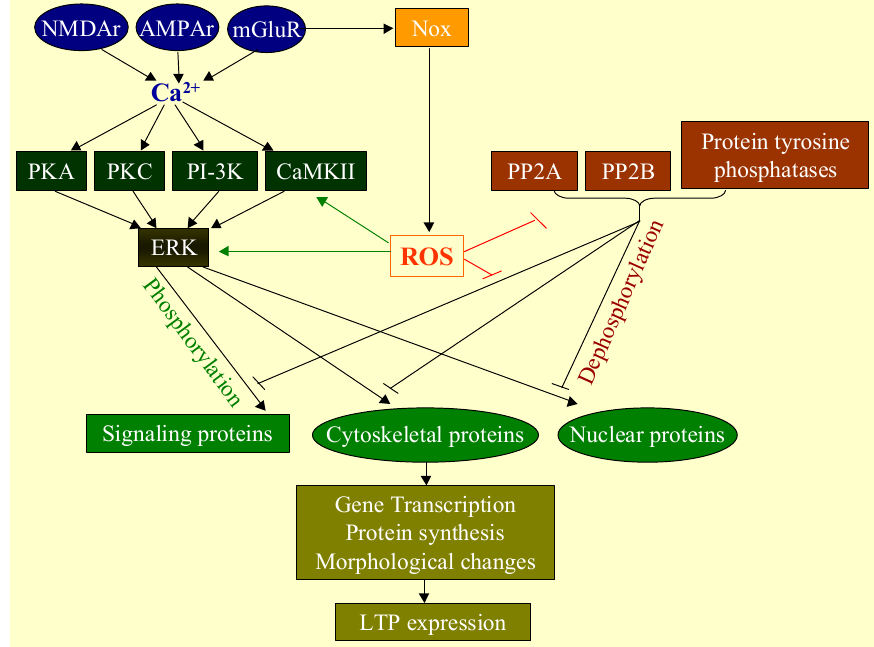
Figure 2. Contribution of ROS to the process of learning and memory. Long-term potentiation (LTP) is considered one of the major cellular mechanisms for learning and memory. It is positively regulated by activation of glutamate receptors,